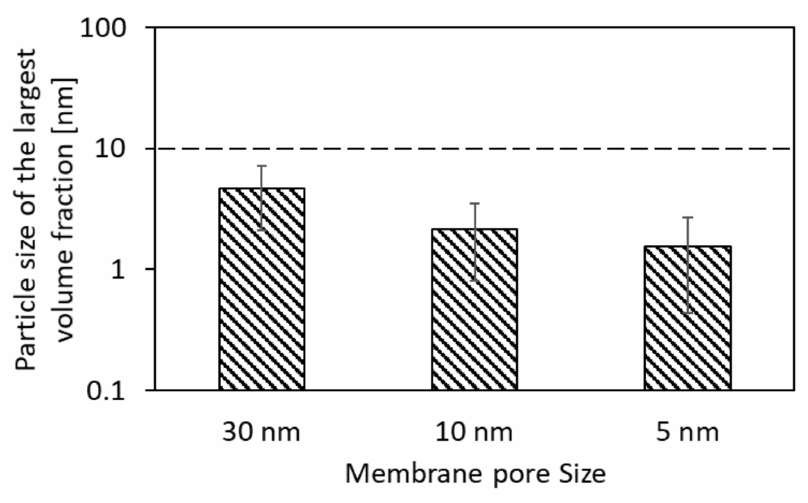
Figure 5. Permeate quality based on the particle size of the largest volume fraction of produced permeates for UF membrane-pore sizes of 30, 10 and 5 nm from experiments 1, 2 and 3, respectively.